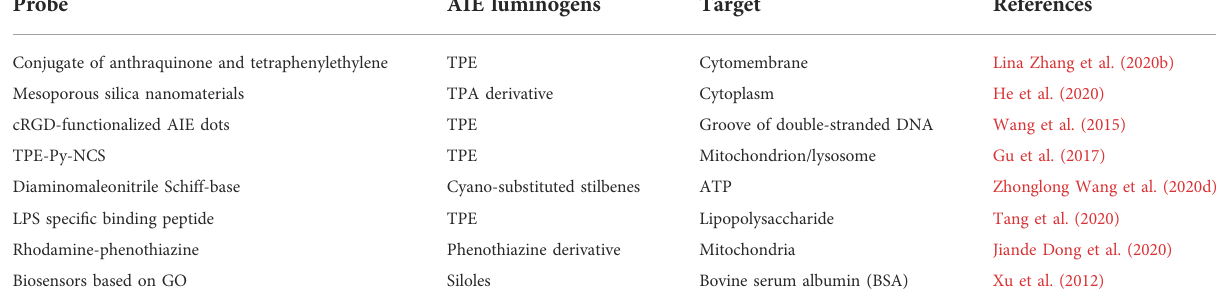
TABLE 2 AIE-based fl uorescent probe for biosensing.